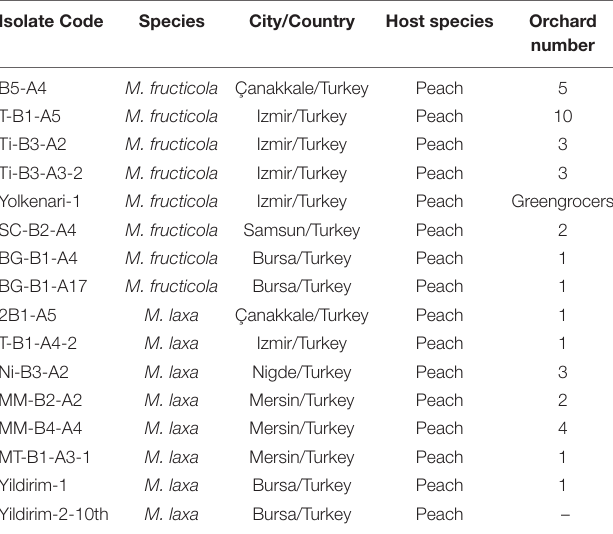
TABLE 1 | The list of selected fungal isolates from M. fructicola and M. laxa species. Isolate Code